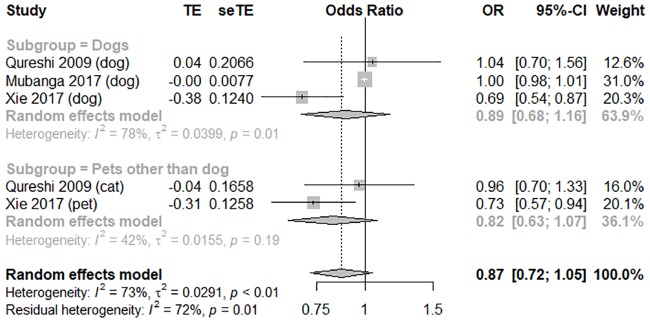
A forest plot showing the risk of cardiovascular disease, comparing pet owners and non-pet owners, with a subgroup analysis by pet type.CI, confidence interval; OR, odds ratio; SE, standard error; TE, treatment effect.